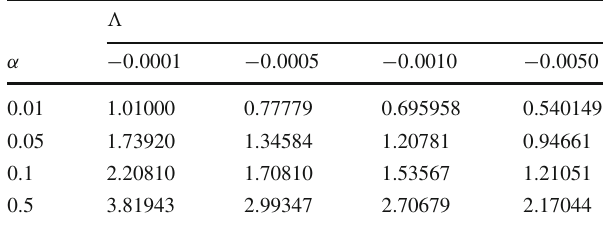
Table 1 The values of the ISCO radius r isco are tabulated in the case of massive particles moving around a 3 D GB black hole for different values of GB parameter α and cosmological constant (cid:4)